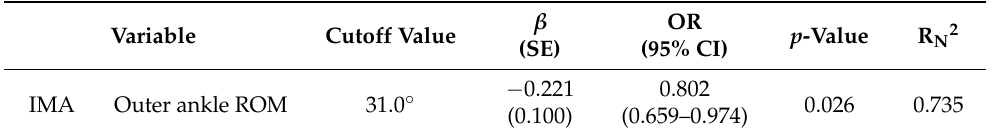
Table 3. Stepwise binary logistic regression analysis results for freezers and non-freezers during the 180 ◦ turning